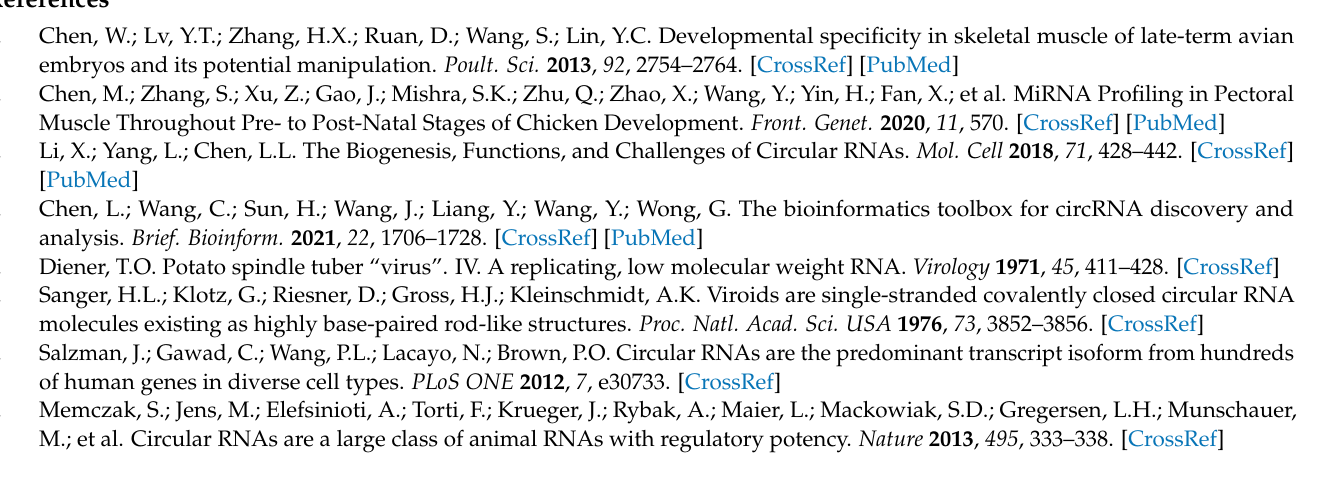
CHD1 gene, Figure S2: Original agarose gel electrophoresis for PCR products of divergent primers, Table S1: Results of quality control, Table S2: Results of mapping to the genome, Table S3: Differential analysis results of S14 vs. F14, Table S4: Differential analysis results of S20 vs. F20, Table S5: GO enrichment result of S14 vs. F14, Table S6: GO enrichment result of S20 vs. F20, Table S7: KEGG vs. F20, Table S9: GO_BP terms related to skeletal muscle development for the co-differentially expressed